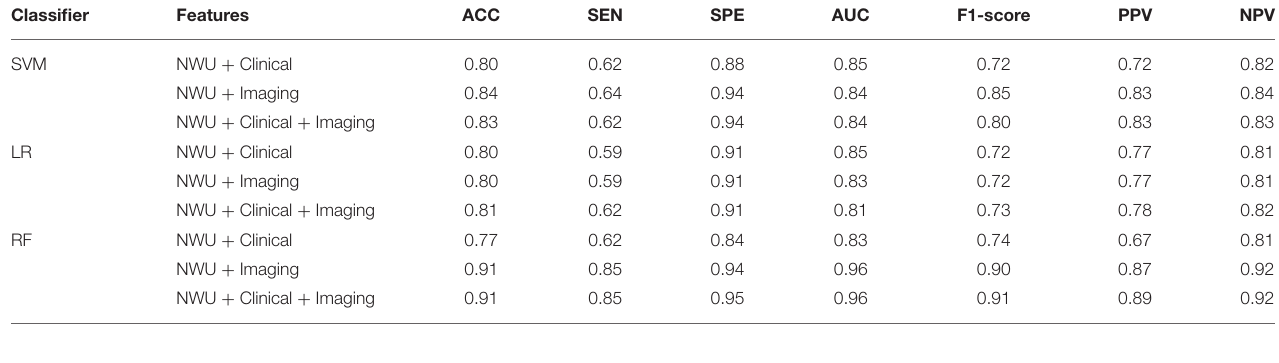
TABLE 2 | Performance comparison of different radiomics models for predicting MCE. Classifier